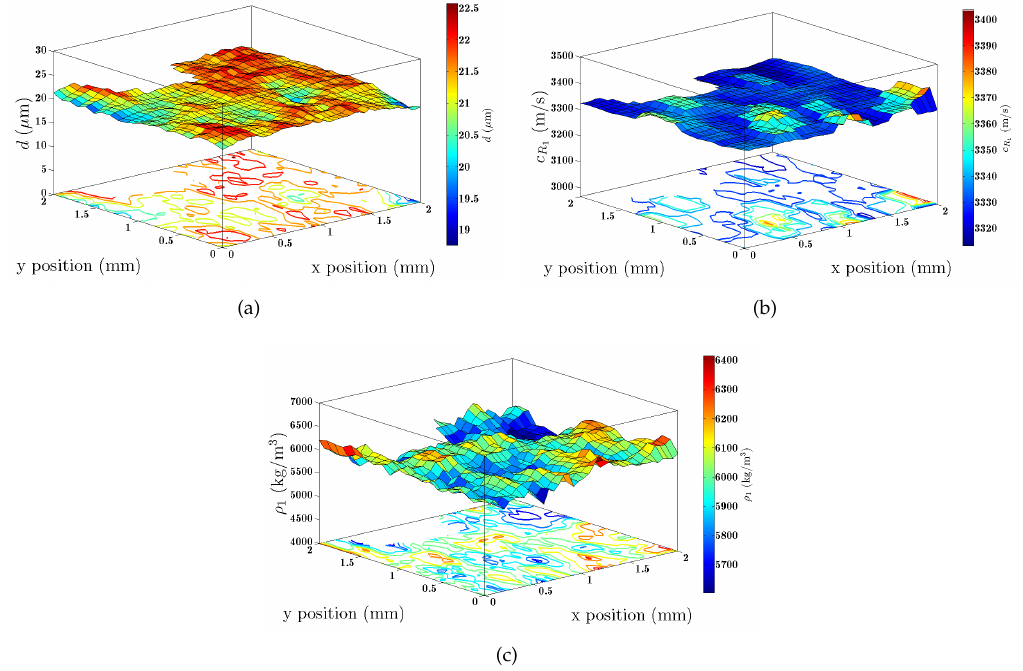
Figure 11. Surface plots of the best fitting parameters (( a ) coating thickness, ( b ) coating Rayleigh velocity and ( c ) coating density) obtained by fitting each position dependent acoustic dispersion curve to the coating-substrate model. For the sake of clarity, contours of constant parameter values were added to each surface plot. Around x = 0.6 mm and y = 2 mm no results are shown due to poor data quality at these